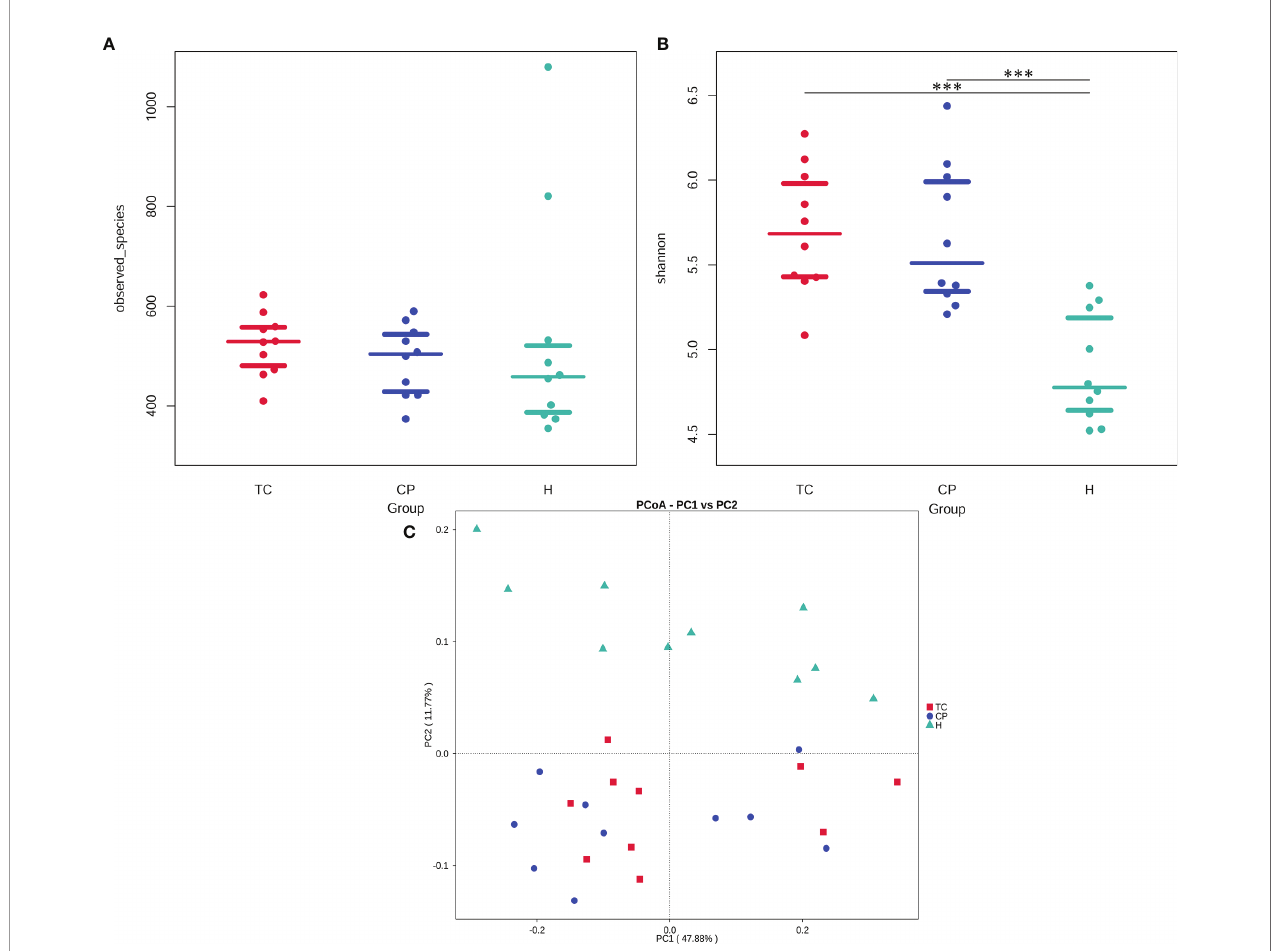
FIGURE 2 | Diversity analysis plot. (A) Beeswarm of the observed species index. (B) Beeswarm of the Shannon index. (C) Principal coordinate analysis (PCoA) plot. The samples of the same group in the fi gure are represented by the same color, each point represents a sample, and the distance between the points represents the degree of